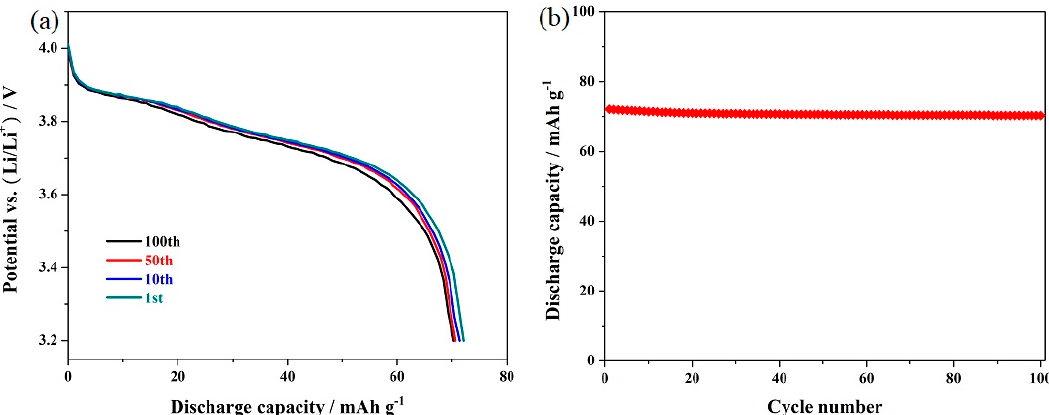
Figure 6. ( a ) Initial discharge curves and ( b ) cycling performance of the octahedral LiMn 1.95 Mg 0.05 O 4 sample at 10 C.